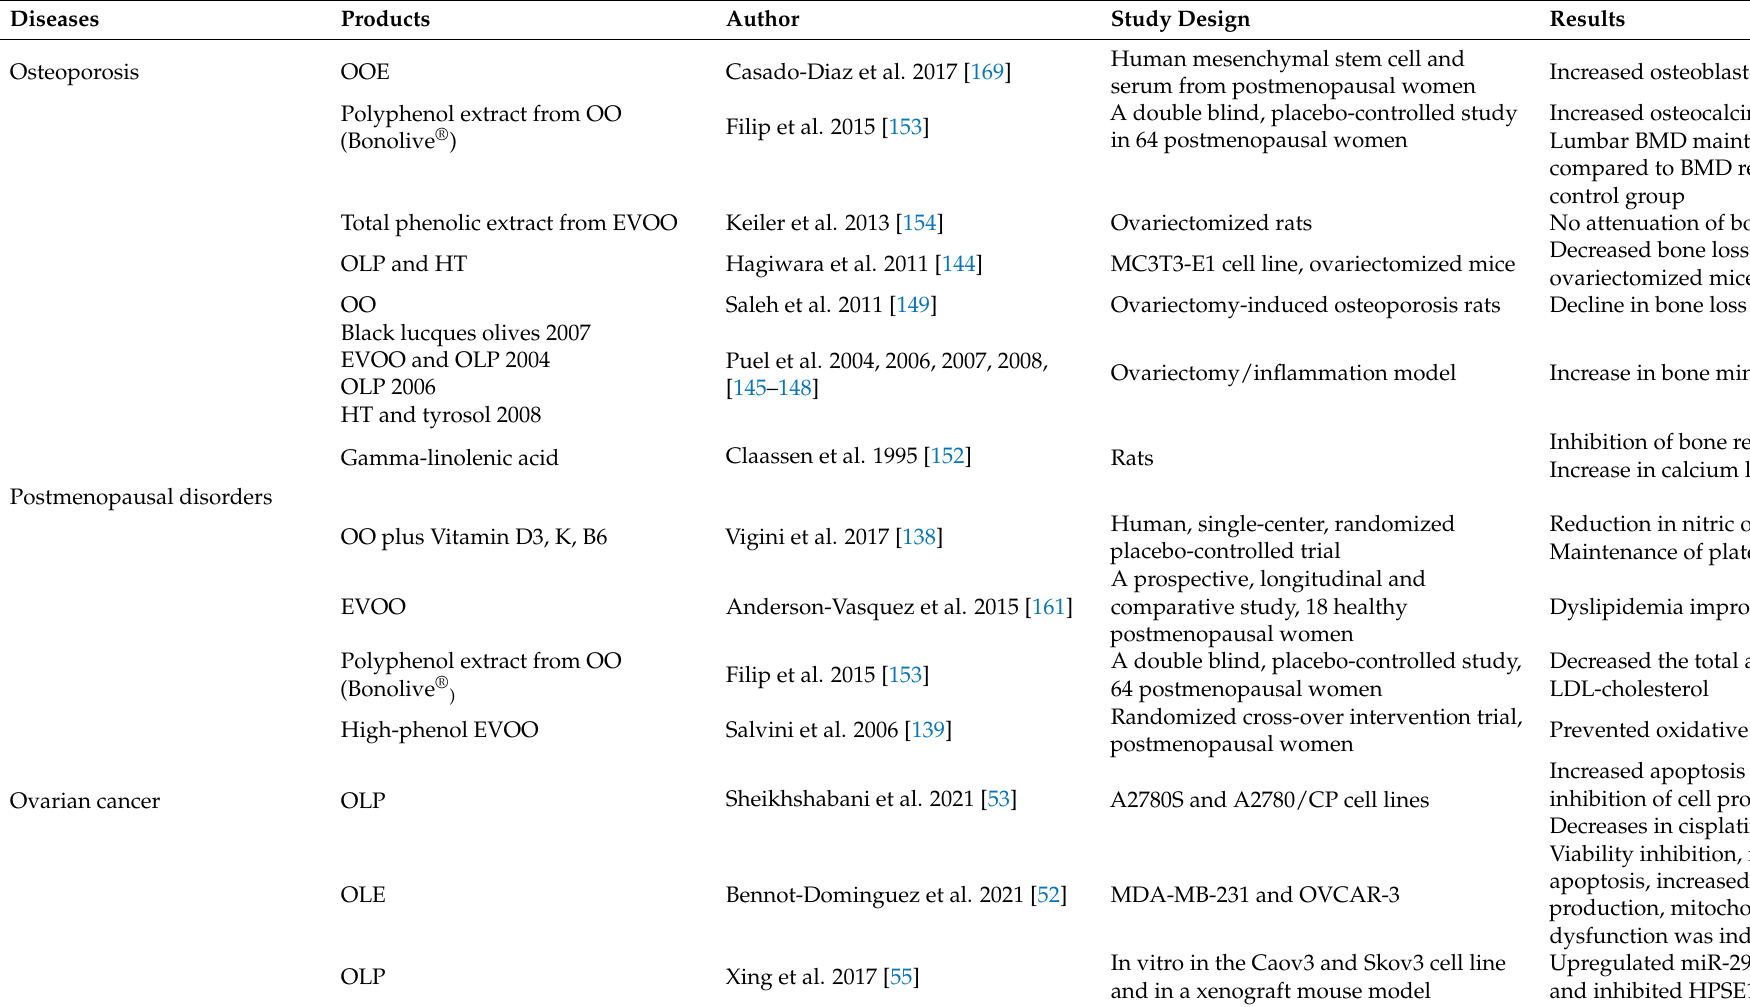
Table 1. The role of OO in various aspects of women’s